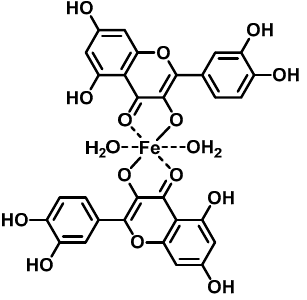
Figure 4. Structure of tested iron-quercetin complex.